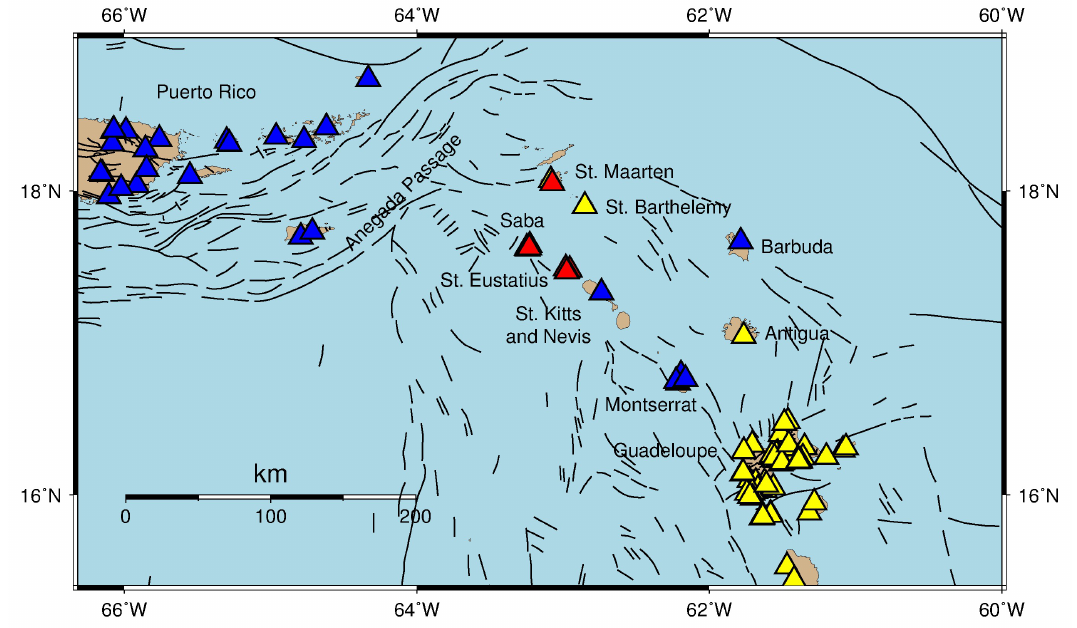
Figure 4. Operating seismic stations around Saba and St. Eustatius. Station metadata provided by IRIS (blue; www.iris.edu) and by ORFEUS/EIDA (yellow: www.orfeus-eu.org/data/eida). NA stations are marked in red. Tectonic faults are as in Figure